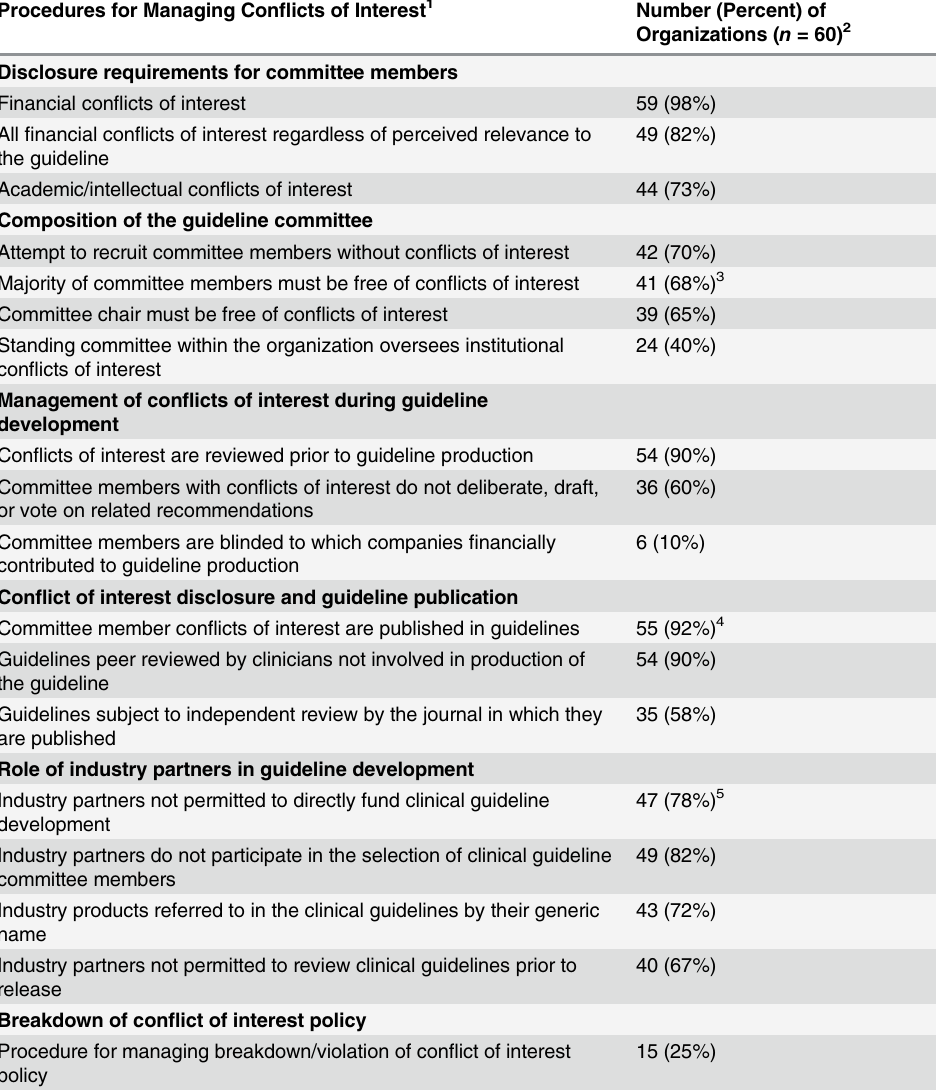
Table 2. Procedures for managing conflicts of interest reported by organizations producing clinical practice